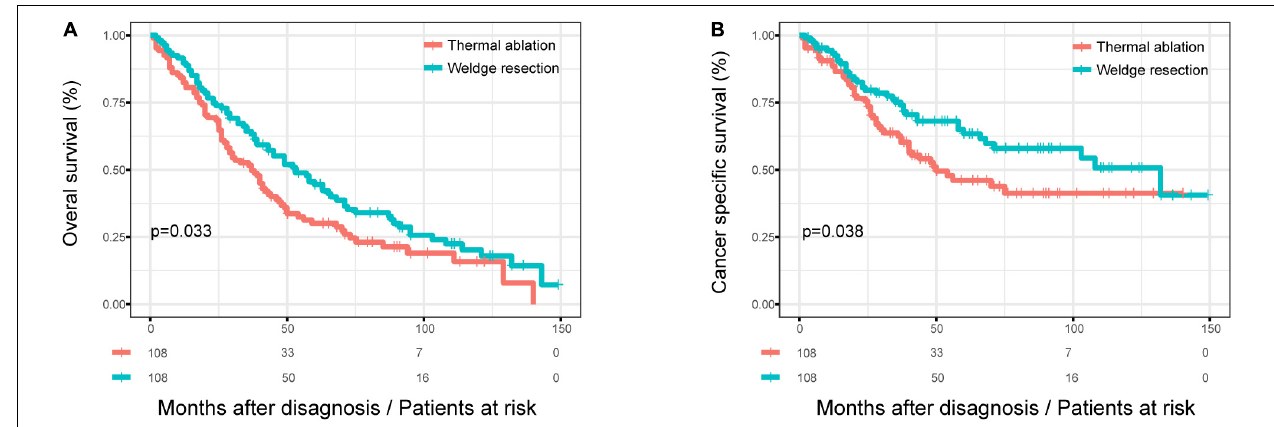
FIGURE 2 | The OS and CSS curves in stage I NSCLC patients who received thermal ablation or wedge resection after PSM. (A) The OS curve of stage I NSCLC patients who received thermal ablation or wedge resection after PSM ( χ 2 = 4.567, p = 0.033). (B) The CSS curve of stage I NSCLC patients who received thermal ablation or wedge resection after PSM ( χ 2 = 4.297, p = 0.038).